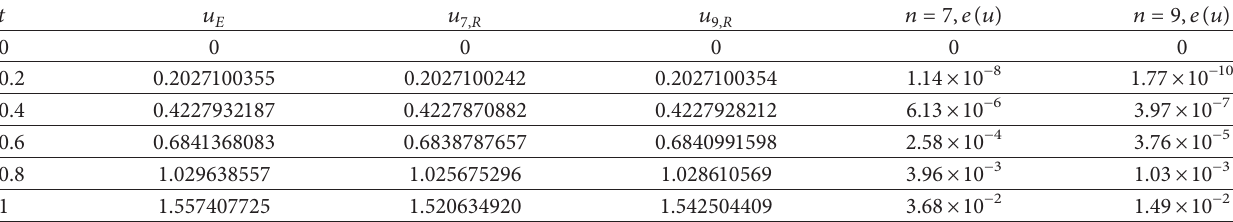
Table 3: Numerical result of Example 2.